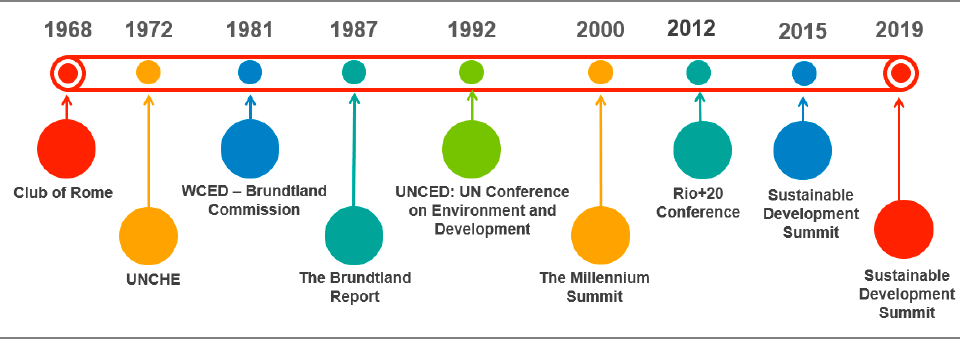
Figure 1. Historical timeline of summits addressing sustainability [1].